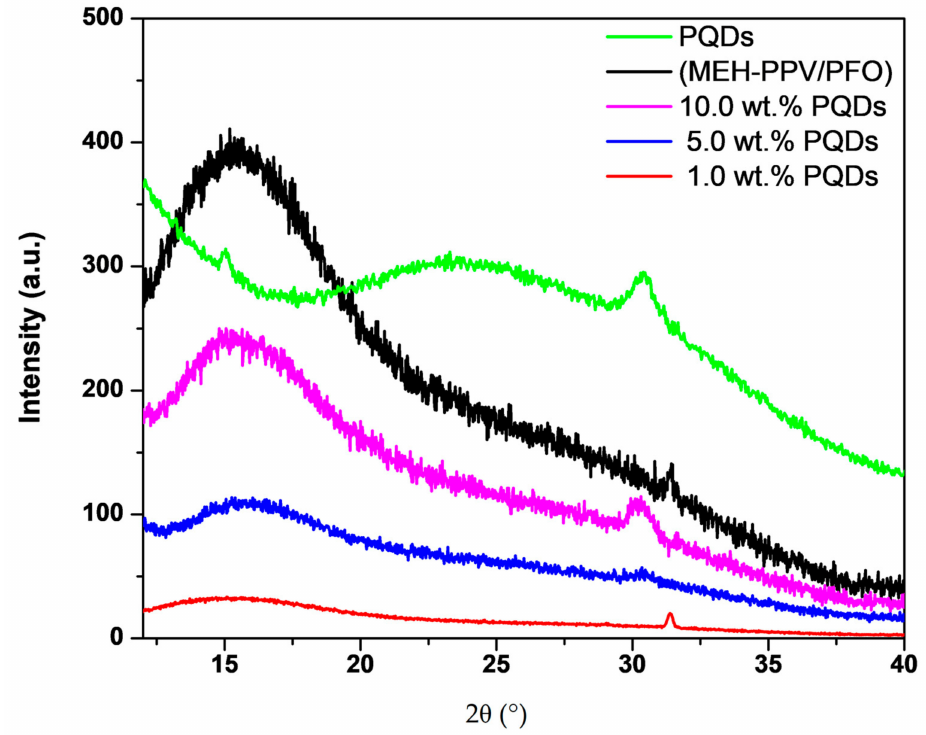
Figure 2. XRD diffractograms of the poly[2-methoxy-5-(2 (cid:48) -ethylhexyloxy)-1,4-phenylene vinylene] (MEH–PPV)/poly(9,9-di- n -octylfluorenyl-2,7-diyl) (PFO) hybrid, CsPbBr 3 -PQDs, and PQDs/(MEH– PPV/PFO) composite